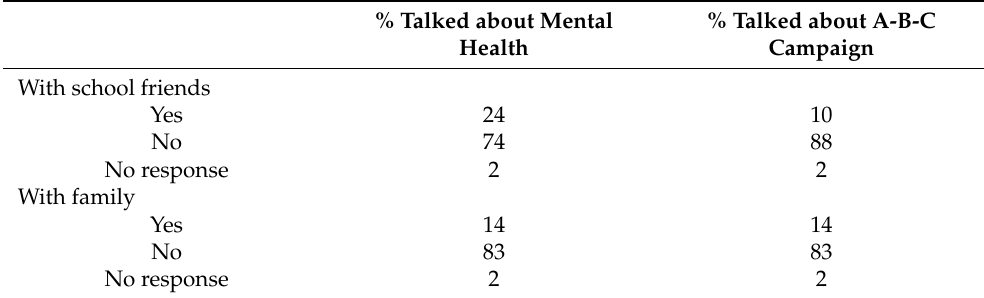
Table 3. Campaign impact on talking about mental health or the campaign with school friends and family: % of follow-up students aware of Act–Belong–Commit (n = 43).